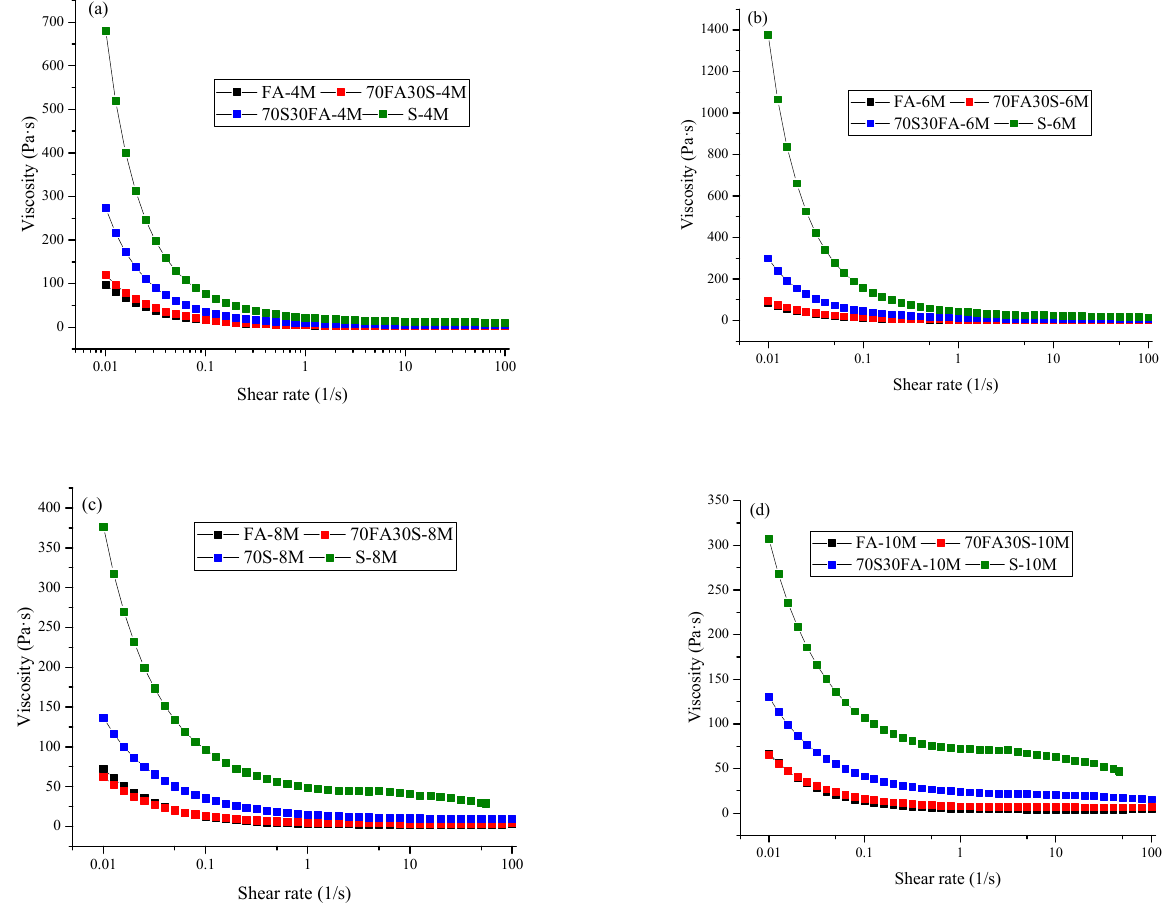
Figure 2. Viscosity curves for alkali activated mixes: NaOH molarity of ( a ) 4 M, ( b ) 6 M, ( c ) 8 M and ( d ) 10 M.